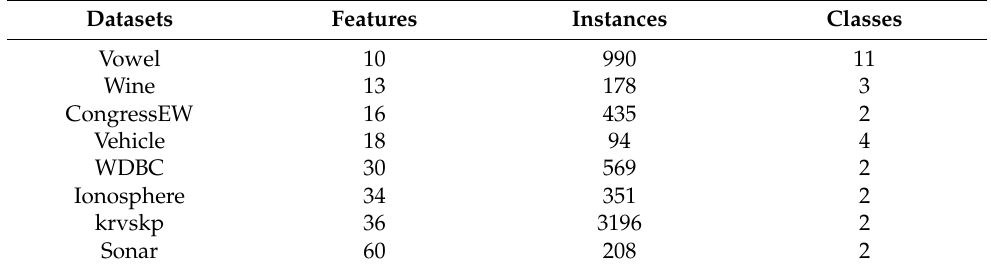
Table 4. Details of 8 repository datasets.